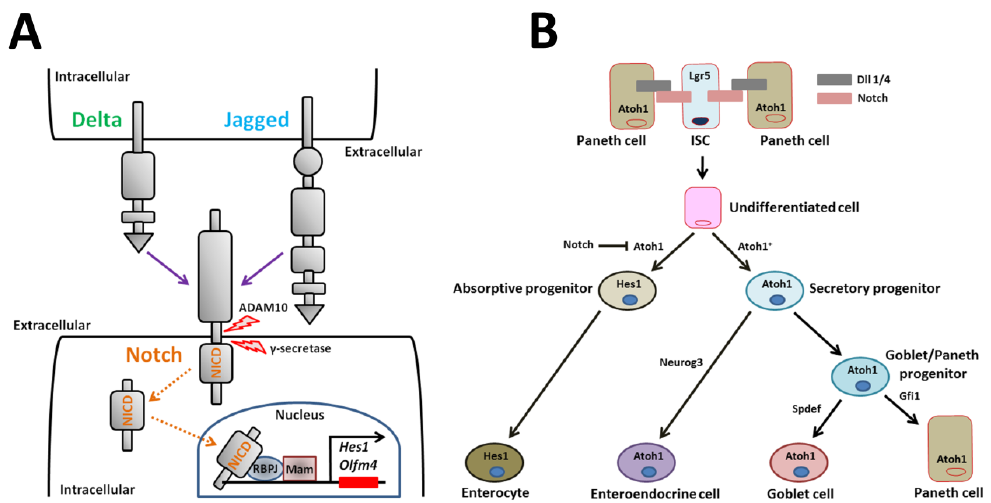
Figure 3. Notch signaling and model for Notch regulation of small intestinal epithelial cell differentiation. ( A ) Transmission of Notch signaling involves engagement of two cells. The signal-sending cell expresses the Notch ligands, Delta and Jagged. The signal-receiving cell expresses Notch receptors. After ligand/receptor engagement, the Notch receptor is proteolytically cleaved. The cleaved NICD translocates to the nucleus where it recruits a transcriptional coactivator complex that activates downstream transcription of Notch target genes such as Hes1 . ( B ) Notch signaling represses the bHLH transcriptional regulator, Atoh1, to form absorptive enterocytes. Atoh1 + secretory progenitor cells are fated towards three mature secretory cell types. Neurog3 induces enteroendocrine cell differentiation. Spdef regulates Goblet cell differentiation. Gfi1 regulates Paneth cell differentiation. ADAM10: a disintegrin and metalloproteinase 10, NICD: Notch intracellular domain, RBPJ: recombination signal binding protein for immunoglobulin kappa J region, Mam: mastermind, Hes1: Hairy and enhancer of split 1, Olfm4: olfactomedin 4, Atoh1: atonal homolog 1, Lgr5: leucine-rich repeat-containing G-protein coupled receptor 5, ISC: intestinal stem cell, Dll: delta-like ligand, Neurog3: neurogenin 3, Gfi1: growth factor independent 1, Spdef: sterile alpha motif pointed domain containing ETS transcription factor.